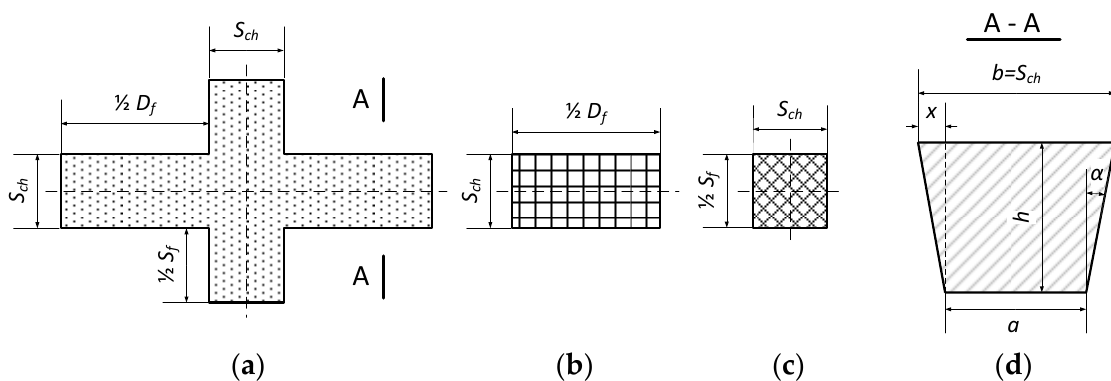
Figure 5. Geometric figures describing the volume of the excavation for the entire field of exploitation during the cross- cutting stage, along with a cross-section: ( a ) “cross”; ( b ) “right” and “left”; ( c ) “top” and “bottom”; ( d ) trapezoidal excavation [24].